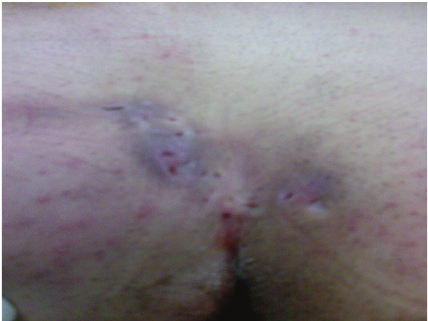
Figure1:Demonstrationofthecomplexpilonidalsinusdiseasewith multiple pits on and beside the natal cleft.